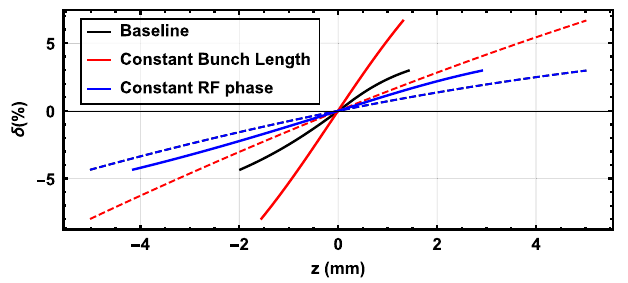
FIG. 4. Longitudinal phase space of chirped bunches before (dashed) and after (solid) compression. The baseline bunch (black) is accelerated 20° on the falling side of the crest (over- lapped by dashed blue line) and compressed with R 56 ¼ − 0 . 1 m and linearized with T 566 ¼ − 0 . 70 m. After reducing R 56 to − 0 . 05 m, a bunch of equal initial length (red) requires accel- eration ∼ 40 ° off-crest with T 566 ¼ − 0 . 08 m. If the rf phase is kept constant (blue), the final bunch length increases and the T 566 required for linearization remains unchanged.